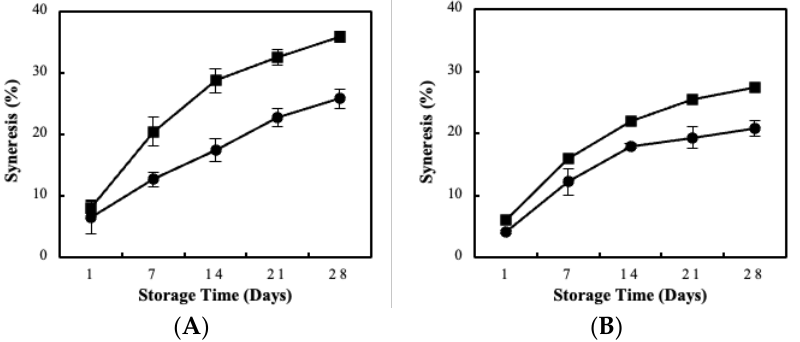
Figure 6. Syneresis changes of sour milk produced by free ( • ) and blended BC immobilized biocatalyst ( (cid:4) ) of L. pentosus B329 ( A ) and L. plantarum 820 ( B ) during storage in 28 days (4 ◦ C).